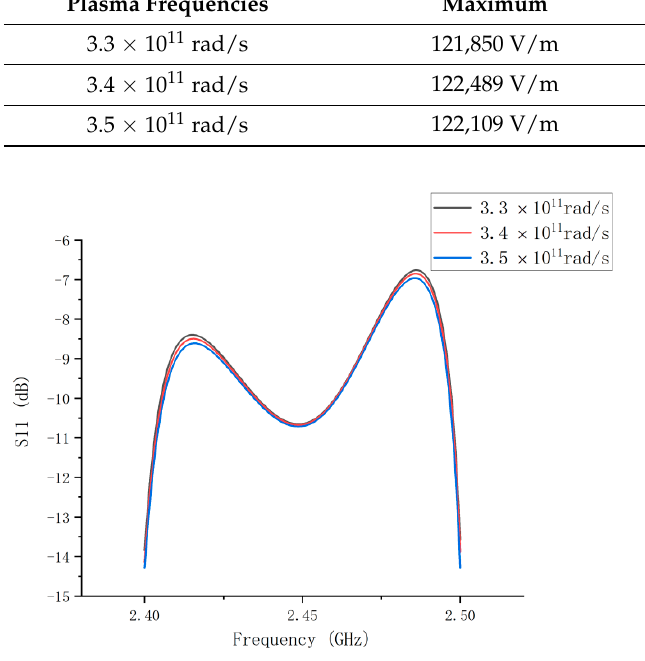
Figure 9. Electric field distributions at different plasma frequencies: ( a ) 3.3 × 10 11 rad/s, ( b ) 3.4 × 10 11 rad/s, and ( c ) 3.5 × 10 11 rad/s. Table 3. Maximum and average values of the electric field at different plasma frequencies.